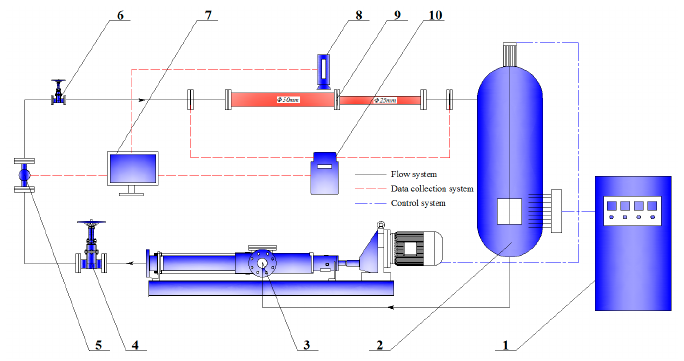
Figure 5. Schematic diagram of the experimental set-up: (1) Electrical control cabinet; (2) liquid storage tank containing the electric heater (2 m 3 ); (3) screw pump; (4) (6) gate valve; (5) flow meter; (7) computer; (8) high-speed camera; (9) test section; (10) pressure transducer.